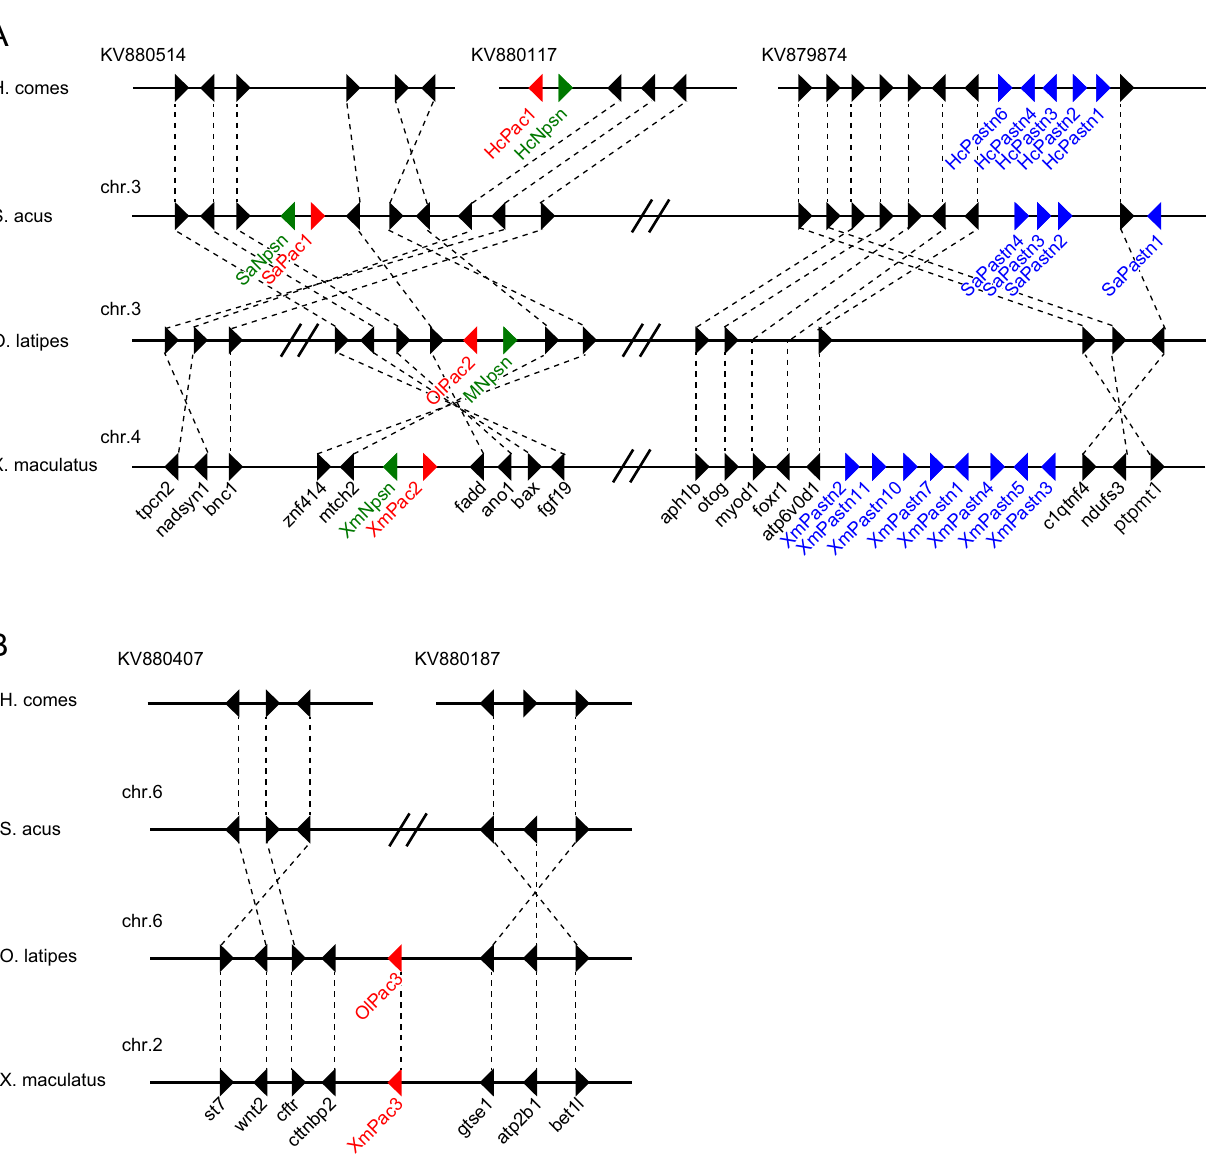
Figure 3. Synteny of genomic regions around ( A ) nephrosin, pactacin (subclades 1 and 2) and patristacin genes, and ( B ) the pactacin (subclade 3) gene of tiger tail seahorse, greater pipefish, medaka, and